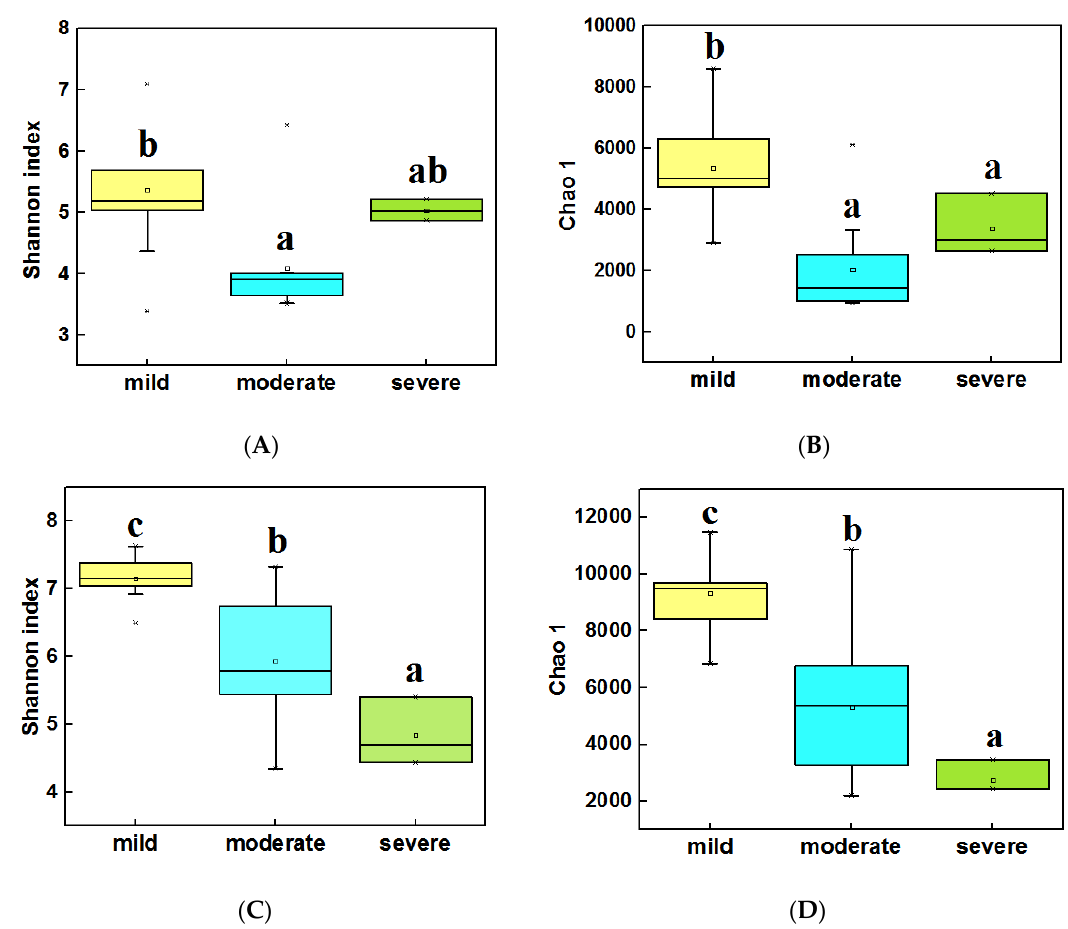
Figure 3. Comparisons of the 16S Shannon index in water samples of three group ponds ( A ). Comparison of 16S Chao1 value in water samples ( B ). Comparisons of 16S Shannon index in sediment samples ( C ). Comparison of 16S Chao1 value in sediment samples ( D ). Different letters are significantly different from one another under three groups, and the significance level is P < 0.05.